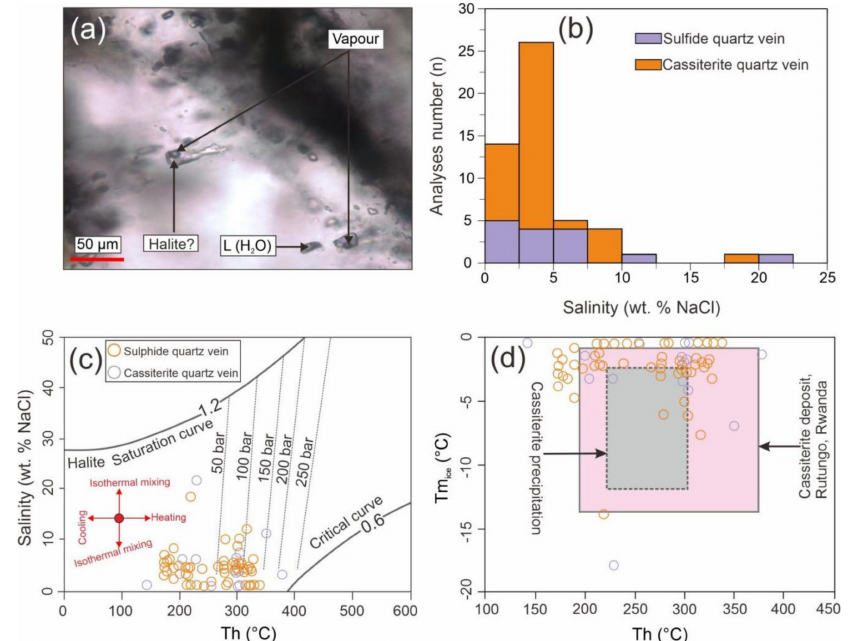
Figure 13. Microphotograph and diagram showing the relationship between salinity, homogenization temperature (Th), and final ice melting temperature (Tm ice ) of the fluid inclusions in cassiterite- and sulfide-bearing quartz vein from the Gindi Akwati deposit. ( a ) Microphotograph showing the primary fluid inclusions; ( b ) Histogram of salinity (wt. % NaCl Equivalent) of sixty-six fluid inclusions; ( c ) Diagram of Salinities vs. Th ( ◦ C) with dashed lines for estimates of the vapor pressure of NaCl solution (modified from [51]). The critical-point (0.6) and halite-saturation curves (1.2) show the densities (g/cm 3 ) of the fluid inclusions (after [52]); ( d ) Th vs. Tm ice plot of aqueous salinity inclusions from the present study, compared with the data of the ambient fluids related to the vein-type Cassiterite deposits of the Rutungo area, Rwanda [53]. It is interpreted that the cassiterite precipitation (minimum formation) occurred from the fluid under these Th and Tm ice values in the field of dashed square [53]. Abbreviation: L(H 2 O) = Liquid H 2 O, Th = Homogenization temperature, Tm ice = Final ice melting